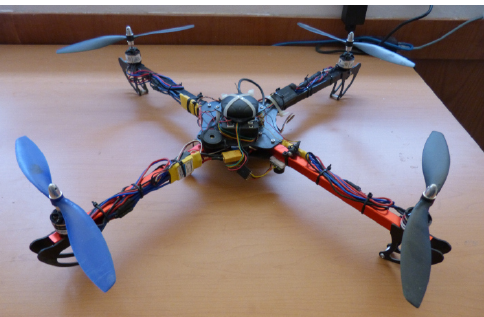
Figure 7. Quadrotor in × configuration whose model parameters were estimated using the proposed method.